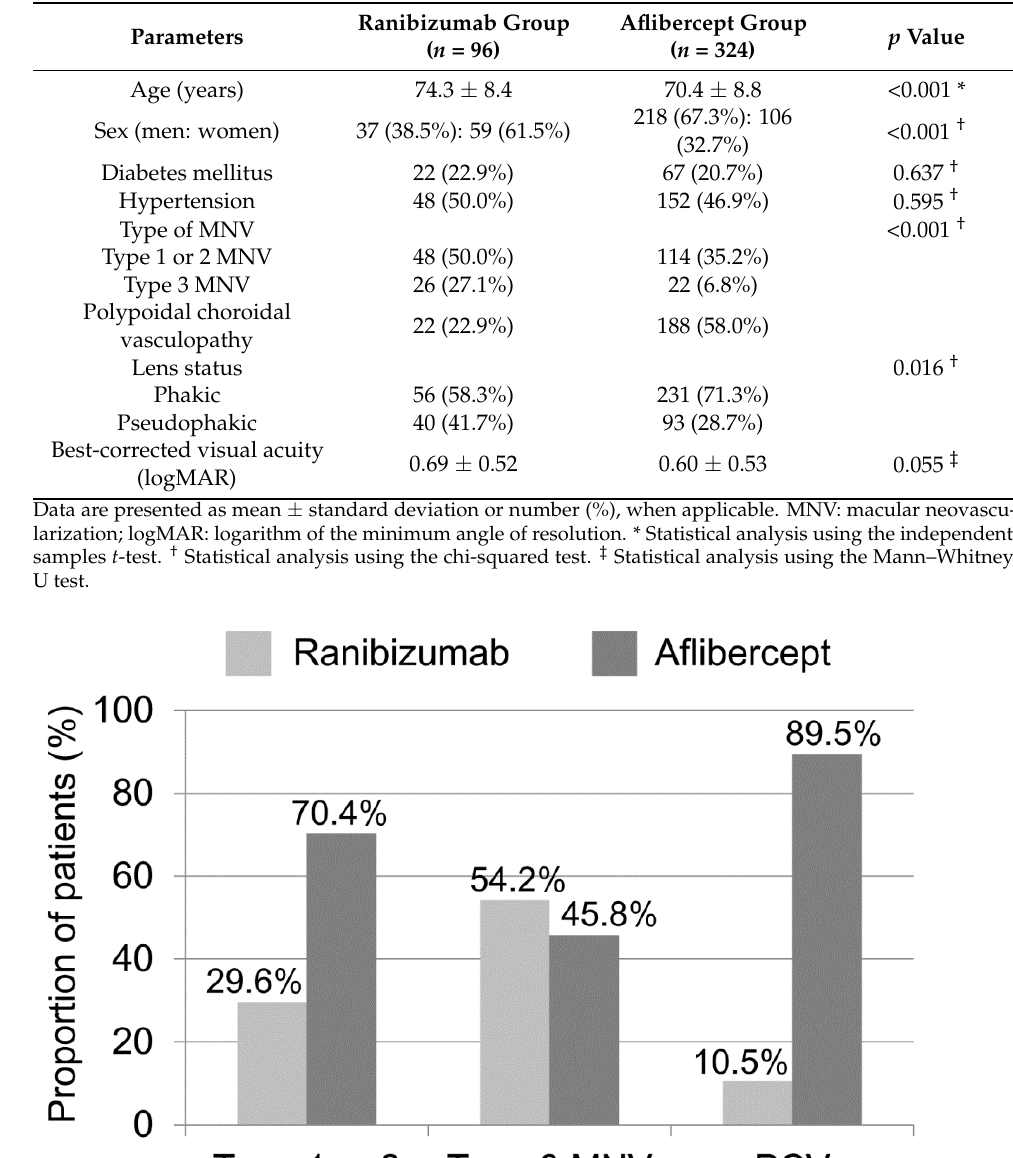
Table 2. Comparison of the parameters between the regression group and non-regression group.